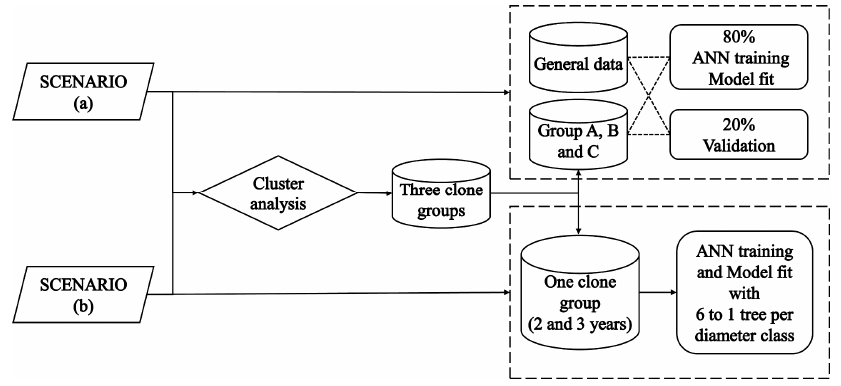
Figure 3. Scheme of the approaches used in scenarios (a) and (b). ANN: artificial neural networks.